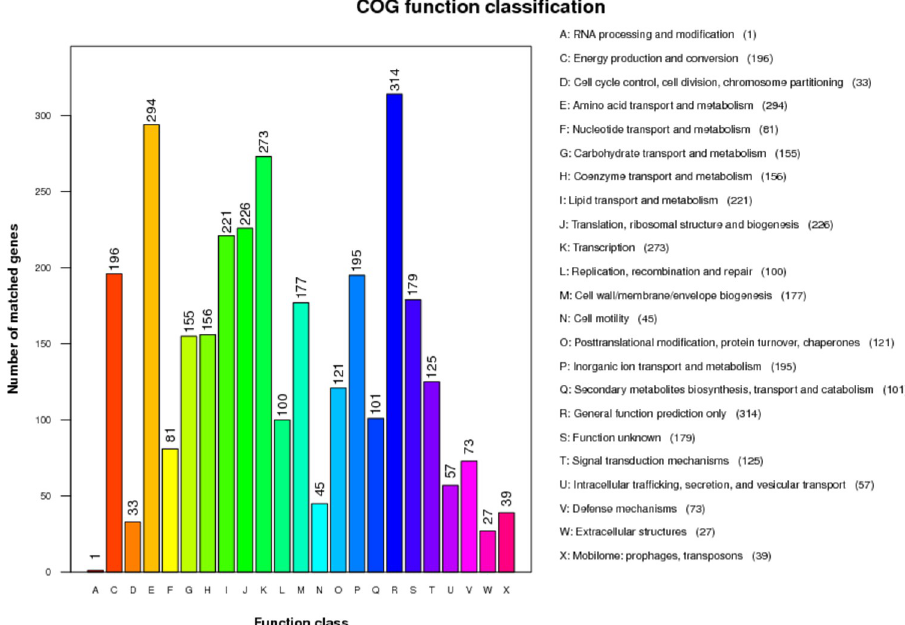
Fig 4. COG annotation of VJR422. The horizontal axis is COG function type, and the vertical axis is the number of annotated